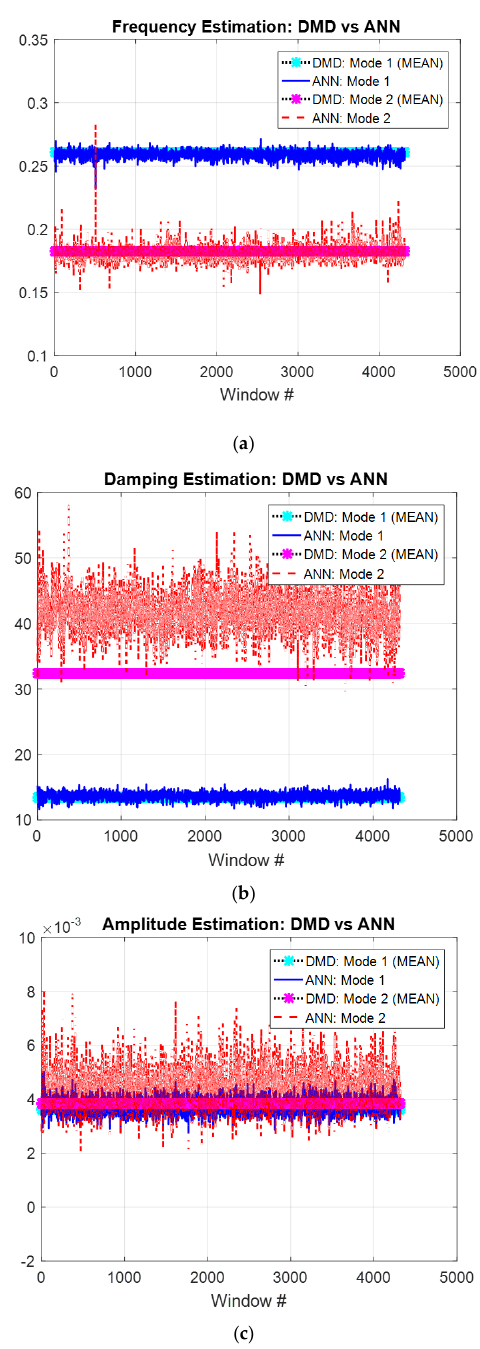
Figure 8. Comparison of the mean value of the estimates produced by DMD (purple thick line) versus the estimates produced by the ANN approach (dashed red line) for the case of DS3 and with a 20 s data frame: ( a ) frequency; ( b ) damping, ( c ) amplitude.